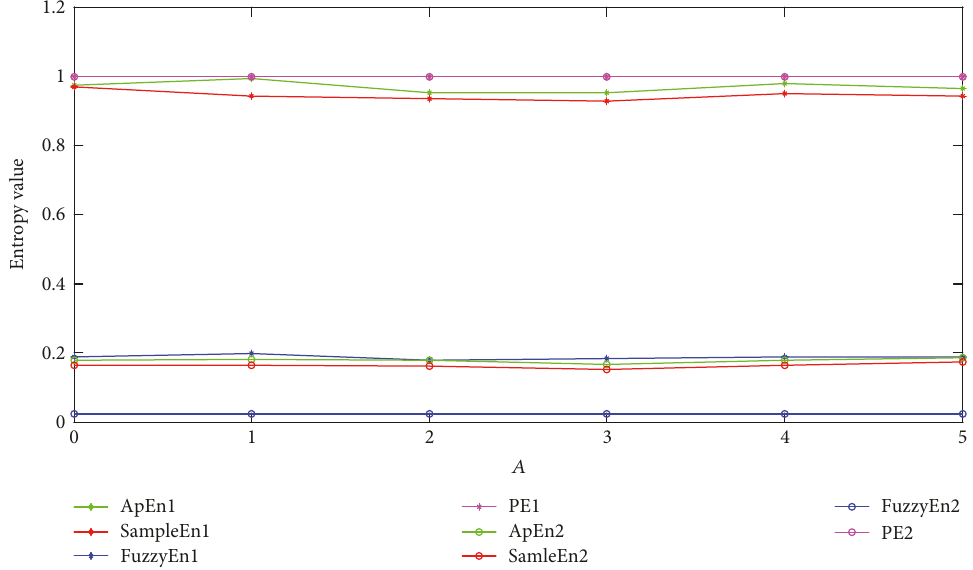
Figure 1: Four kinds of entropy values with di ff erent amplitudes.